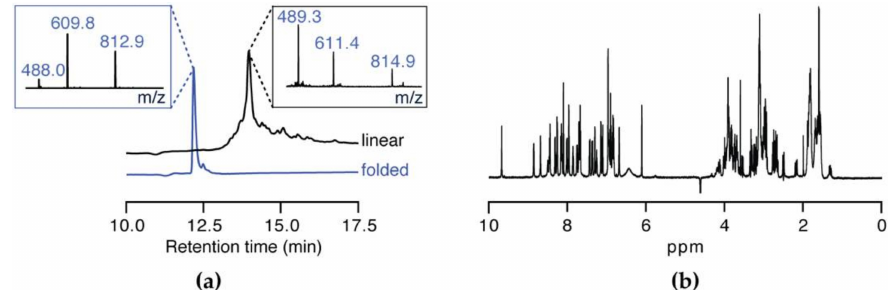
Figure 2. Peptide synthesis of SxIIIC. ( a ) RP-HPLC trace and ESI-MS spectra (insert) after cleavage (top) and oxidation (bottom) confirm successful synthesis and purification of SxIIIC. ( b ) 1D 1 H NMR spectrum of SxIIIC displays well-distributed amide peaks indicating a peptide with a definitive fold.